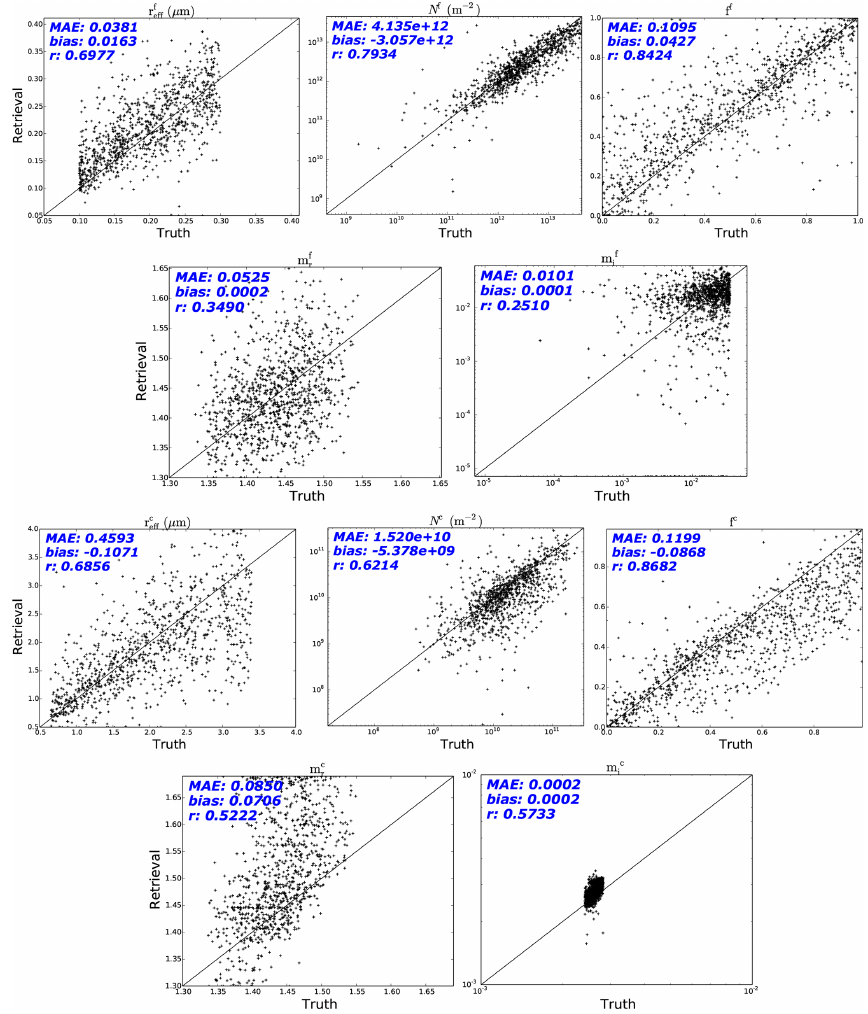
Figure 1. Retrieved microphysical properties versus the truth values of both modes for the HSRL-2 setup with noise, for a total of 997 pixels from 1000 meeting the χ 2 criterion. From top left to bottom right: fine-mode effective radius, fine-mode column number, fine-mode spherical fraction, fine-mode real refractive index at 550nm, fine-mode imaginary refractive index at 550nm, coarse-mode effective radius, coarse- mode column number, coarse-mode spherical fraction, coarse-mode real refractive index at 550nm, and coarse-mode imaginary refractive index at 550nm. Appended to the top left of each plot are the following numbers: the mean absolute error, the average bias, and the correlation coefficient. A positive bias indicates an average overestimation of the particular aerosol microphysical property, and a negative bias denotes that the parameter has been underestimated on